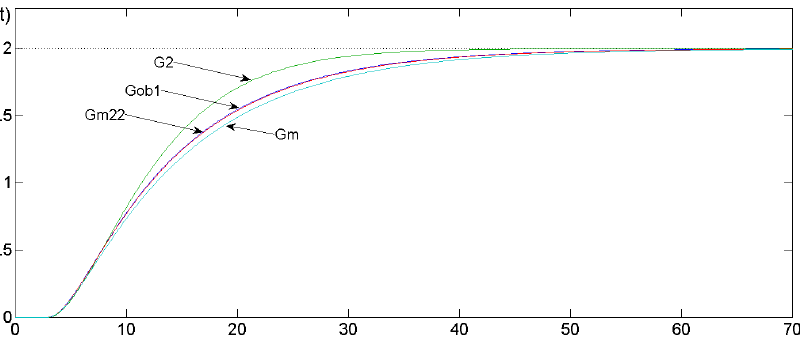
Figure 4. Step characteristics of the plant G ob1 and its models. G m22 —overdamped SOPDT model; G m —SOPDT model with parameters determined during a single relay test; G 2 —critically damped SOPDT model.